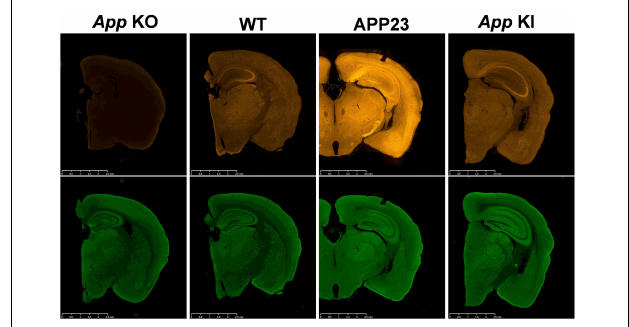
FIGURE 1 | Mislocalization of APP in APP-overexpressing mice. App KO mice, WT mice, APP23 (APP-overexpressing mice) and App KI mice ( App NL − F / NL − F ) were subjected to immunohistochemistry using antibodies to APP, 22C11 (upper panels) and synaptophysin, a synaptic vesicle marker (lower panels) as indicated. App KO mice were used as negative controls for APP staining. While APP is selectively expressed in the axons of WT and KI mice, APP23 expresses unphysiologically high levels of APP not only in the axons but also in the soma and dendrites. The scale bar indicates 2